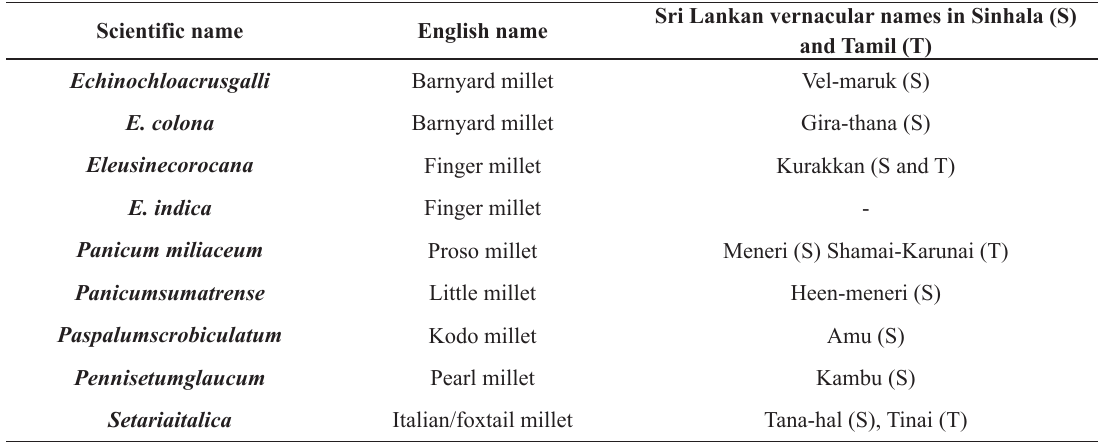
Table 2: Names used in Sri Lanka and elsewhere, to refer to different